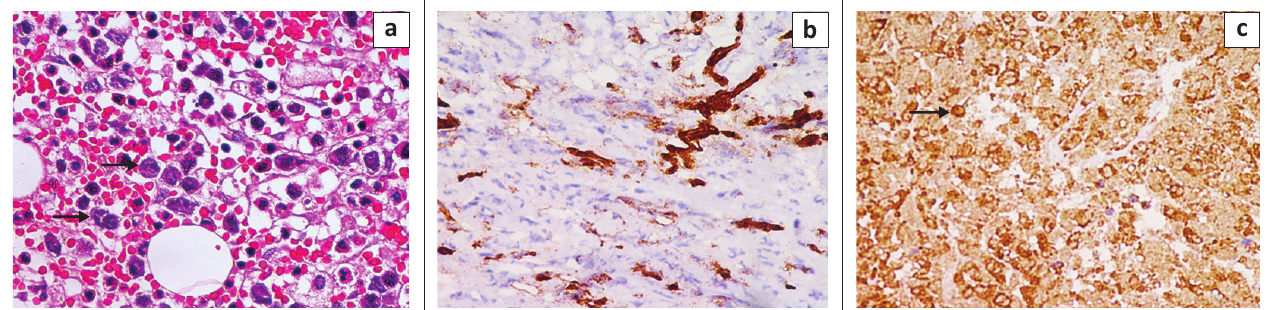
FIGURE 5: (a) The epidural lesion was subsequently biopsied and subjected to microscopic examination. High power field microscopic examination (100× magnification) with hematoxylin and eosin stain shows multiple myeloblasts (arrows) revealing large oval nuclei with a high nucleus:cytoplasmic ratio and prominent nucleoli with intermingled myelocytes showing abundant eosinophillic cytoplasm. High power field examination (100× magnification with special stains reveals that the neoplastic cells show strong positivity for CD34 (b - brown cells) and also stain positive for myeloperoxidase (arrow, c) suggestive of myeloid lineage thereby confirming the diagnosis of granulocytic